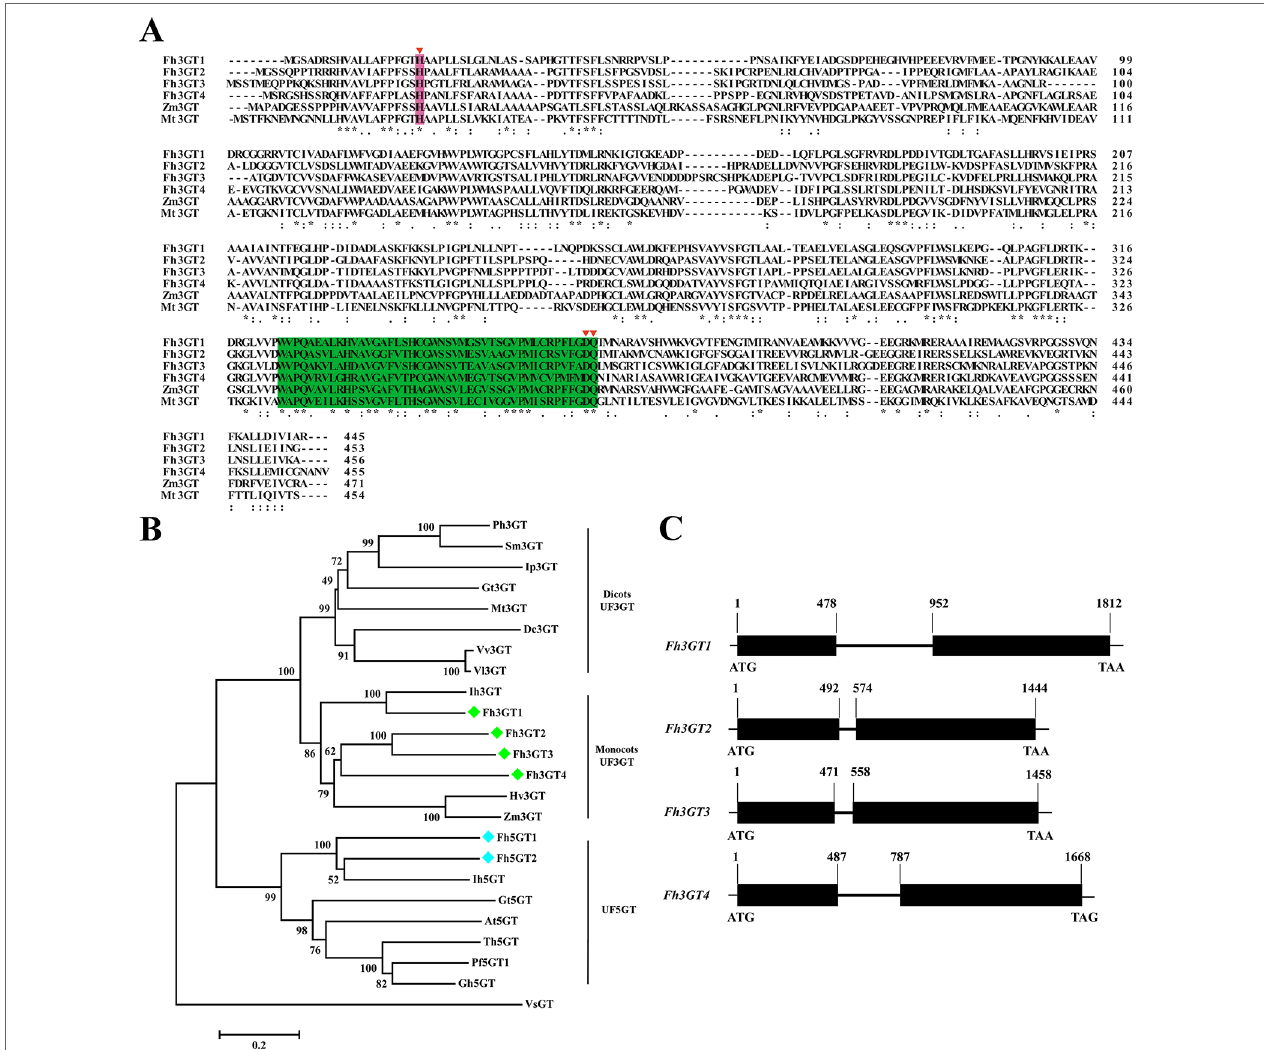
FIGURE 2 | Molecular analysis of Fh3GT proteins. (A) Protein alignment of the potential Fh3GT proteins and their homologs in other species. Numbers indicated the position of the last amino acid in each line. The conserved His and PSPG box were shaded in different colors . *identical amino acids;: or., similar amino acids. (B) Phylogenetic analysis between the predicted Fh3GT proteins and other glycosyltransferases. Numbers indicated bootstrap values for 1,000 replicates. Freesia proteins were indicated as green and blue diamonds . The GenBank accession numbers of the protein sequences used were as follows: Fressia hybrida Fh3GT1 (ADK75021.1), Fh3GT2 (MK945761); Medicago truncatula Mt3GT (XP_003610163); Vitis vinifera Vv3GT (AF000371); Gentiana triflora Gt3GT (D85186), Gt5GT (BAG32255); Petunia hybrida Ph3GT (AB027454); Ipomea purpurea Ip3GT (AF028237); Iris hollandica Ih3GT (BAD83701), Ih5GT (BAD06874); Zea mays Zm3GT (CAA31856); Hordeum vulgare Hv3GT (AA33729); Solanum melongena Sm3GT (Q43641); Dianthus caryophyllus Dc3GT (BAD52003); Vitis labrusca Vl3GT (ABR24135); Perilla frutescens Pf5GT1 (BAA36421); Torenia hybrid Th5GT (BAC54093); Arabidopsis thaliana At5GT (NP_193146); Glandularia hybrida Gh5GT (BAA36423); Viral steroid VsGT (X99073). (C) Genome structures of the potential Fh3GT -like genes. Blank boxes indicated the extrons and numbers indicated the position of nucleotide in the coding